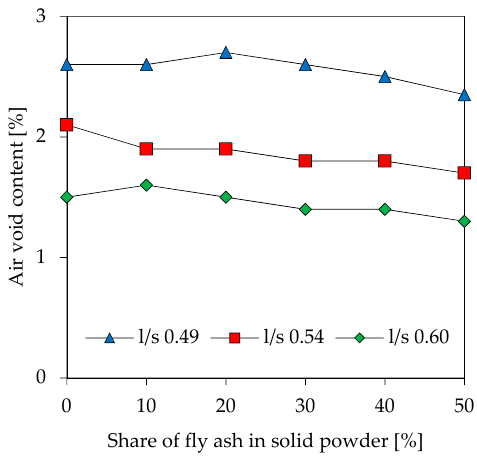
Figure 4. Air void content of fresh geopolymer paste.